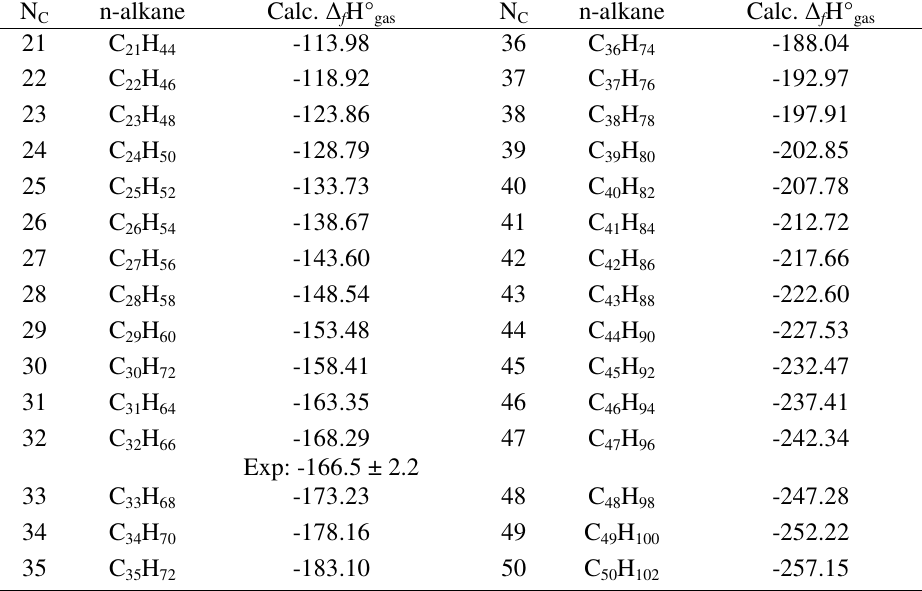
Table 2. Predicted Gas-phase heats of formation ∆ and V computed at B3LYP/6-31++G**, (kcal mol -1 ) S,max N